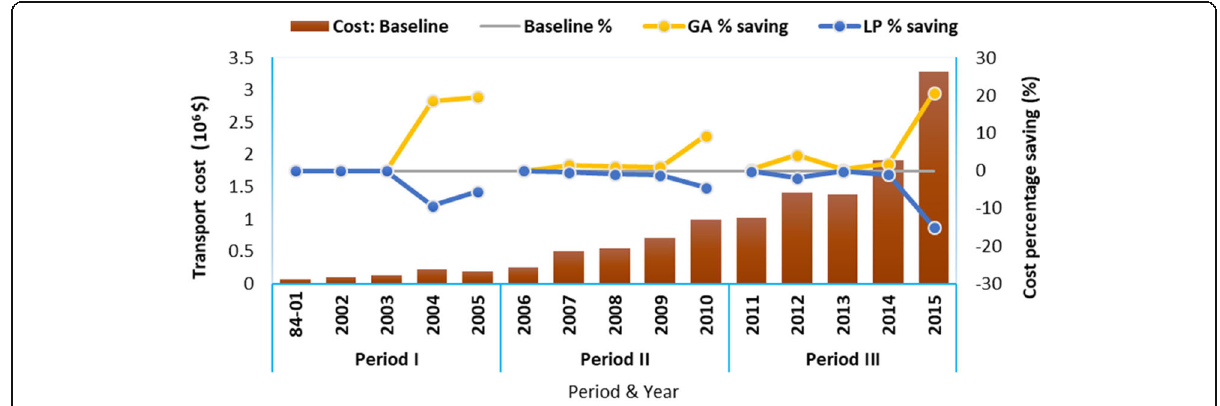
Fig. 2 Transportation cost and cost percentage saving by each method and year